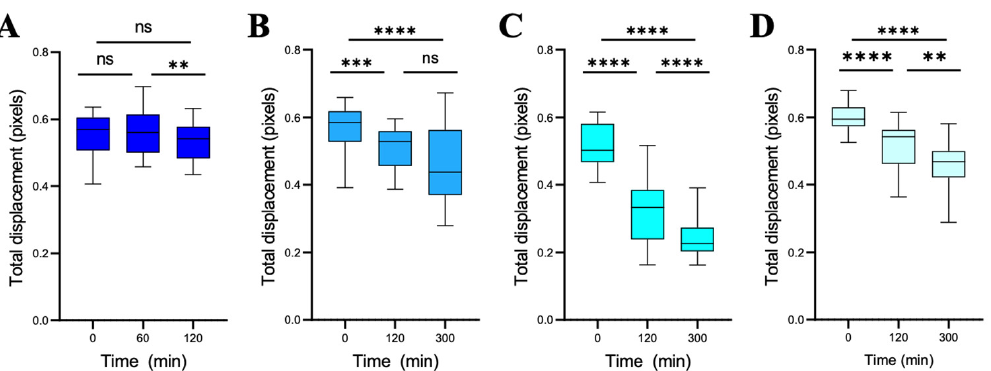
Figure 17. Average cellular nanomotion for 20 cells of C. albicans DSY1024 strain treated with caspofungin. The total displacement of 20 cells was analysed during ( A ) 2 h of growth in a YPD medium (control) and during 5 h of caspofungin treatment with ( B ) 0.5 µ g/mL, ( C ) 1 µ g/mL, and